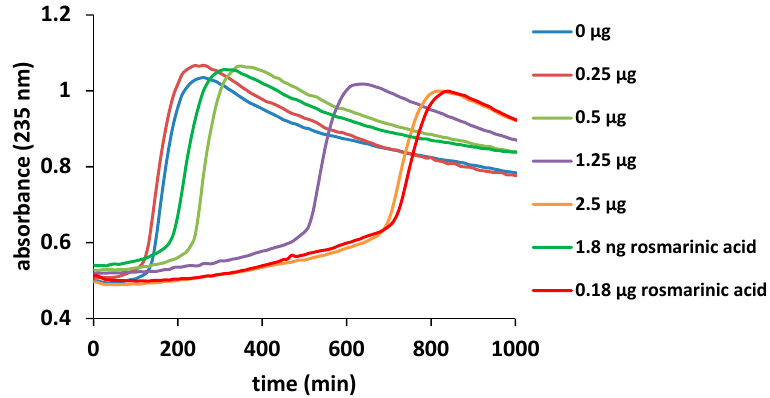
Figure 1. Liposome oxidation by cytochrome c , in the presence of O. vulgare ssp. vulgare extract and rosmarinic acid in the concentration shown in the figure legend.